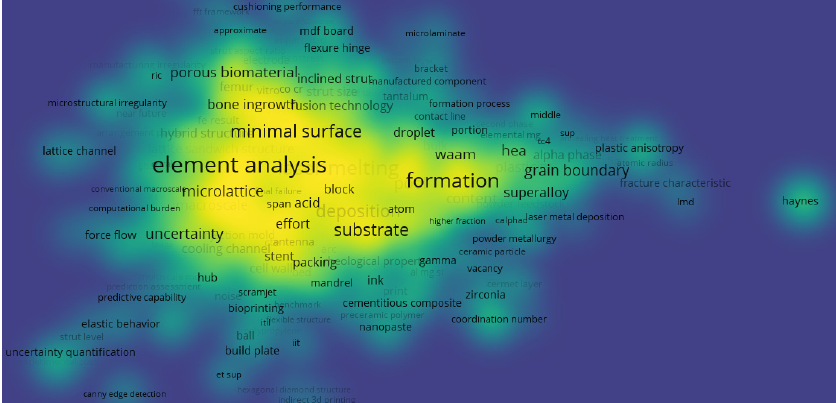
Figure 14. Bibliometric map showing a visualization of the density for keywords published in articles on “additive manufacturing on lattice structure” research (data retrieved from the WoS database on 20 June 2022 and visualized via VOSviewer).